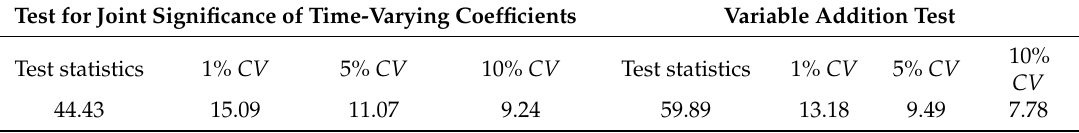
Table 2. Results of the test for joint significance of coefficients and cointegration